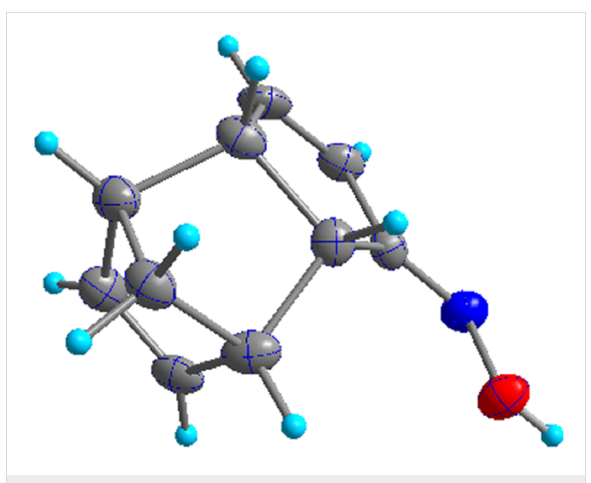
Figure 2: Molecular crystal structure of compound 11b